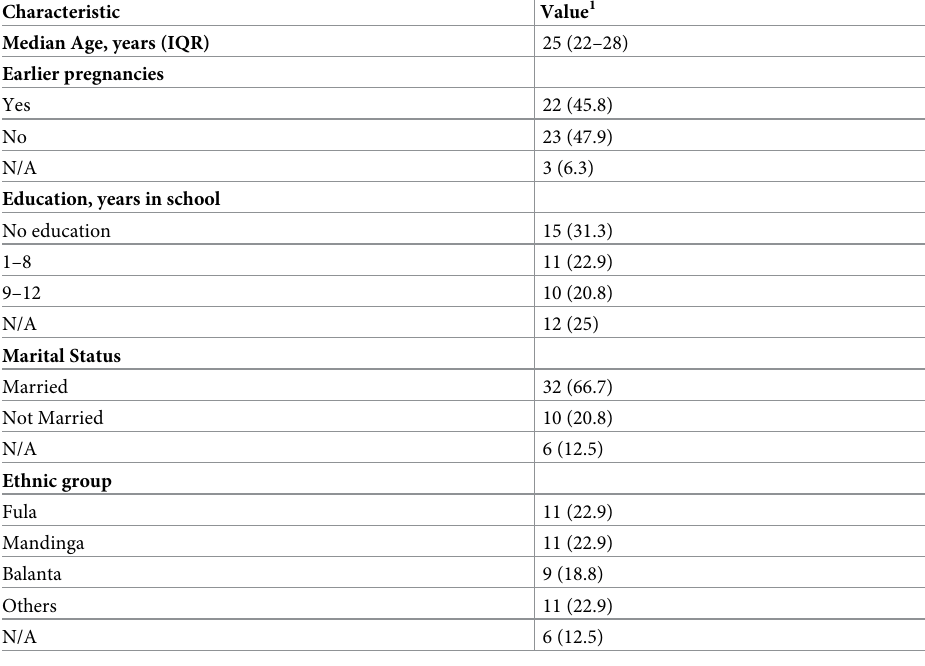
Table 1. Demographic characteristics of enrolled participants (n =